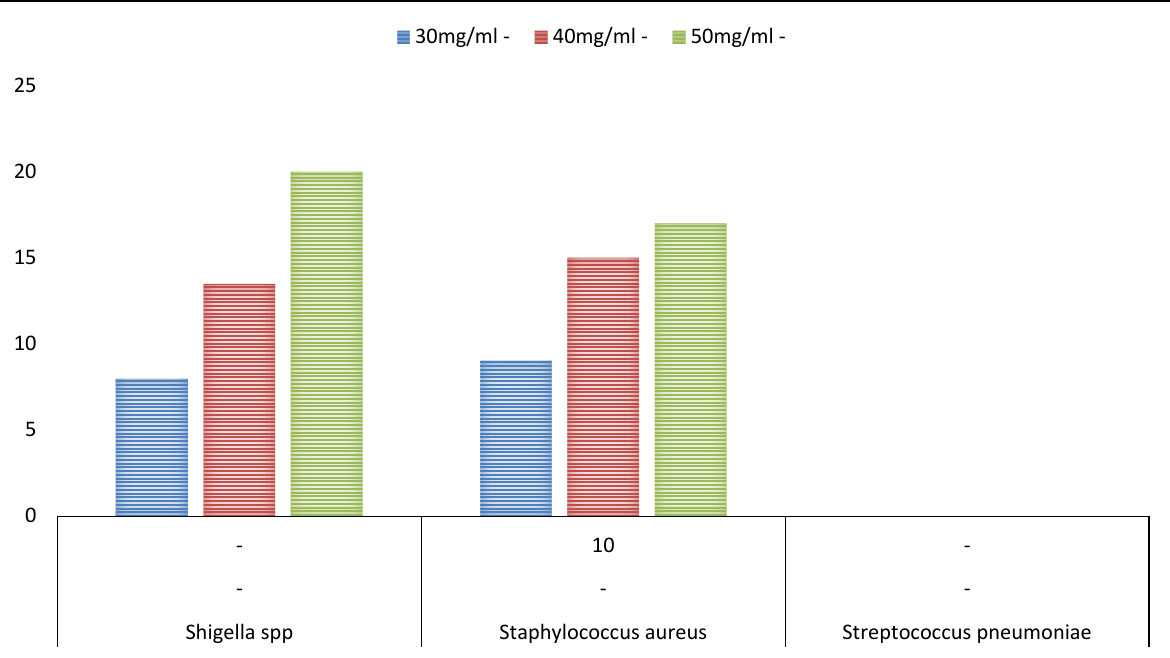
Figure 1. Chart showing zone of inhibition of methanolic extract of Moringa oleifera against the